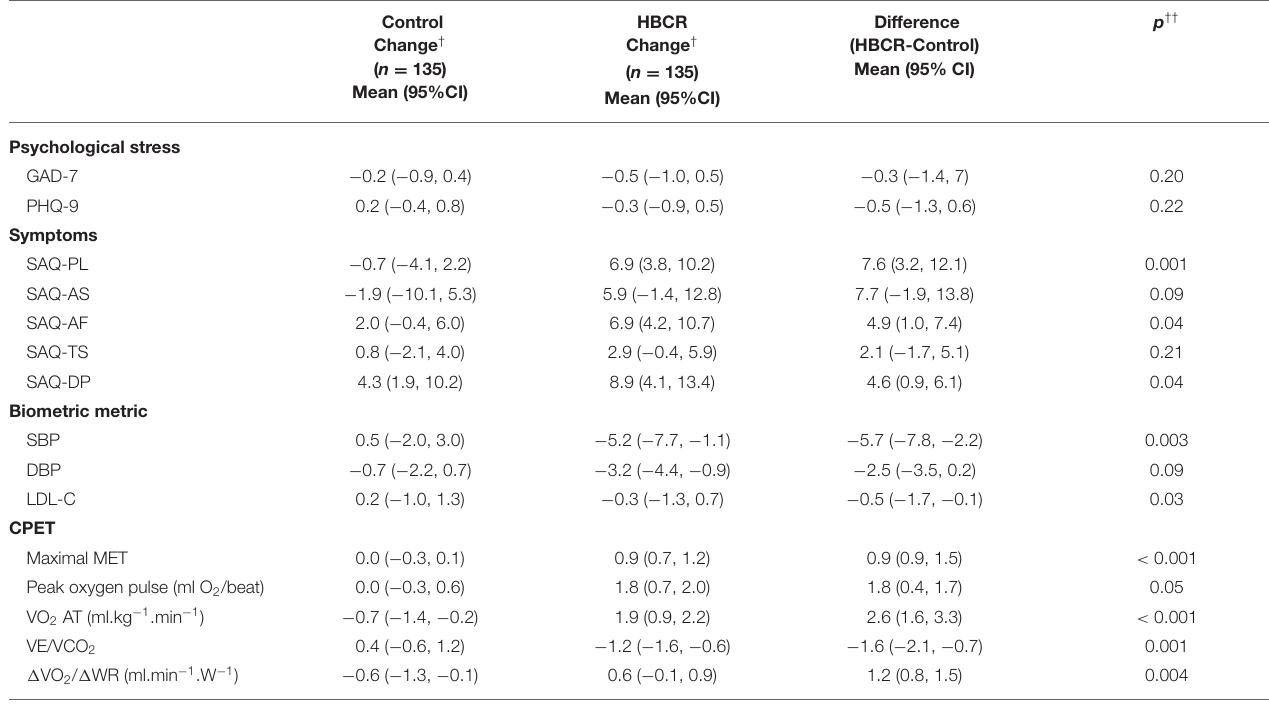
TABLE 4 | Effects of the Home-Based Cardiac rehabilitation program on psychological state, cardiac symptoms and biochemical metric changes for the matched